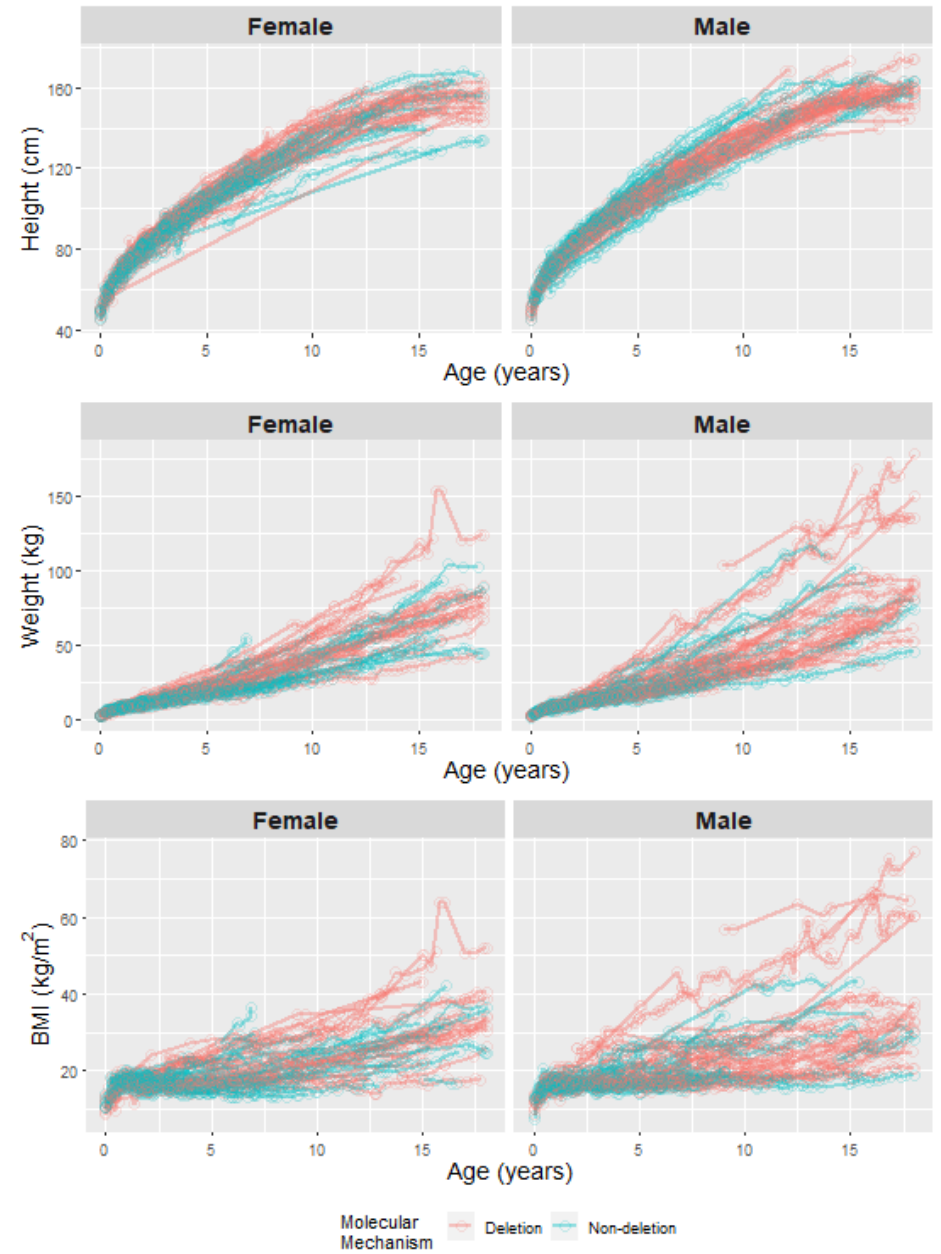
Figure 1. Spaghetti plot of the raw data for each outcome measure from the 125 participants in the study cohort. Table 2. Estimates of mean outcome measure by age for individuals with the deletion or non-deletion mechanism of Prader–Willi syndrome (PWS) in the observed data (without adjustment), estimated using linear mixed models with cubic splines.